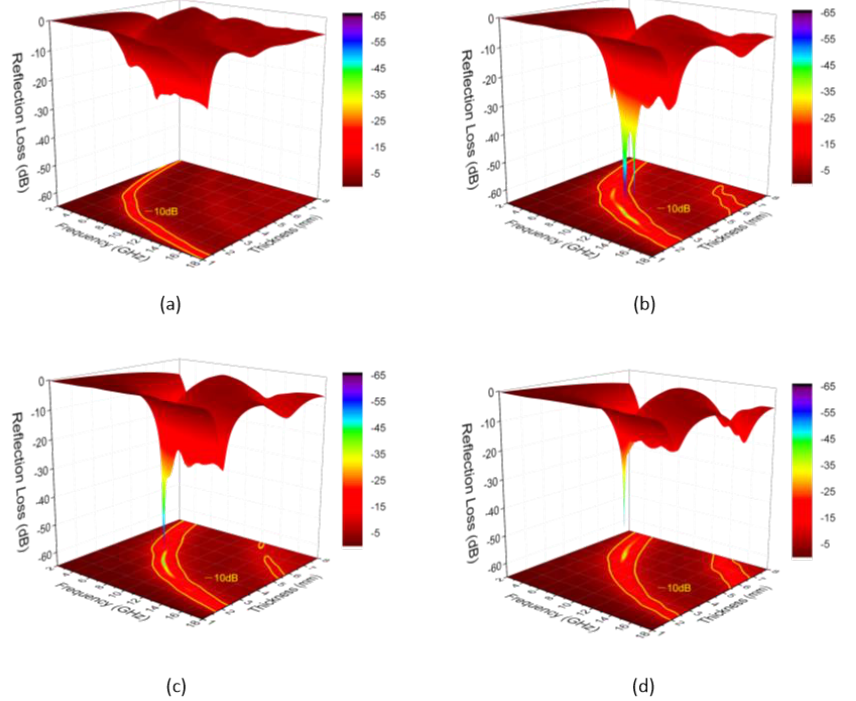
Figure 6. 3D-RL plots of the composites over 2–18 GHz at different thickness of 1–8 mm with the same loading of 40 wt% (a: SiC nw ; b: SCF1-1; c: SCF2-2; d: SCF4-4).